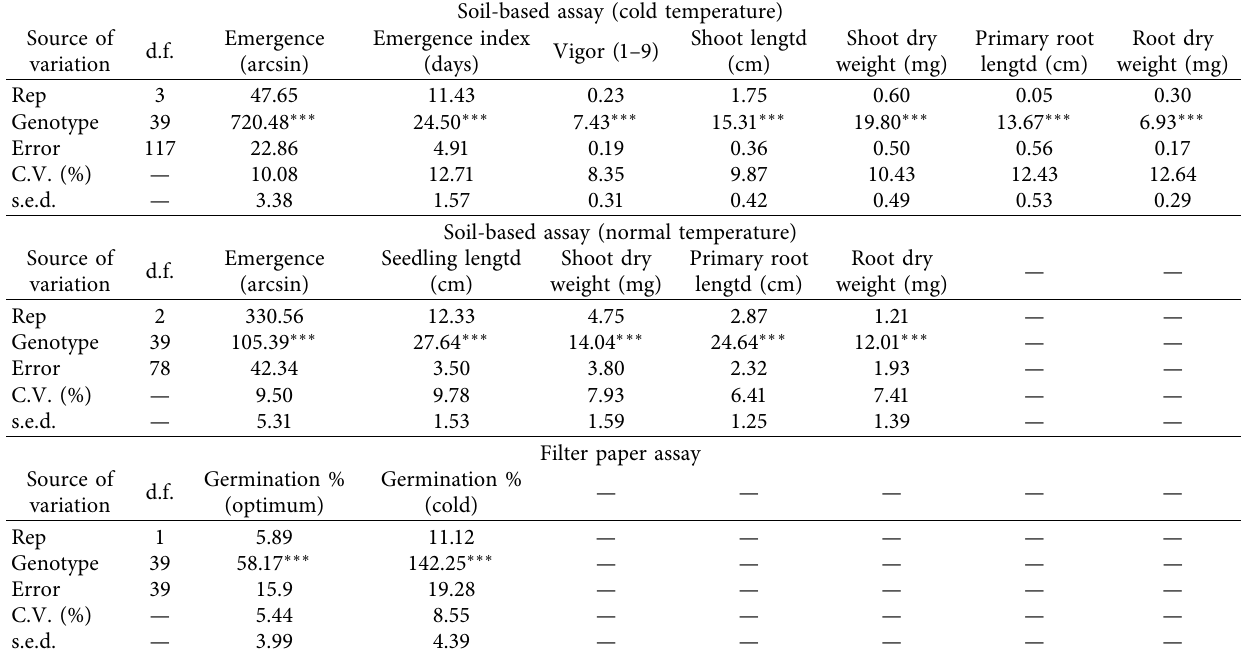
Table 6: Mean squares from analysis of variance for cold tolerance traits under soil-based conditions (cold and normal temperatures) and the filter paper